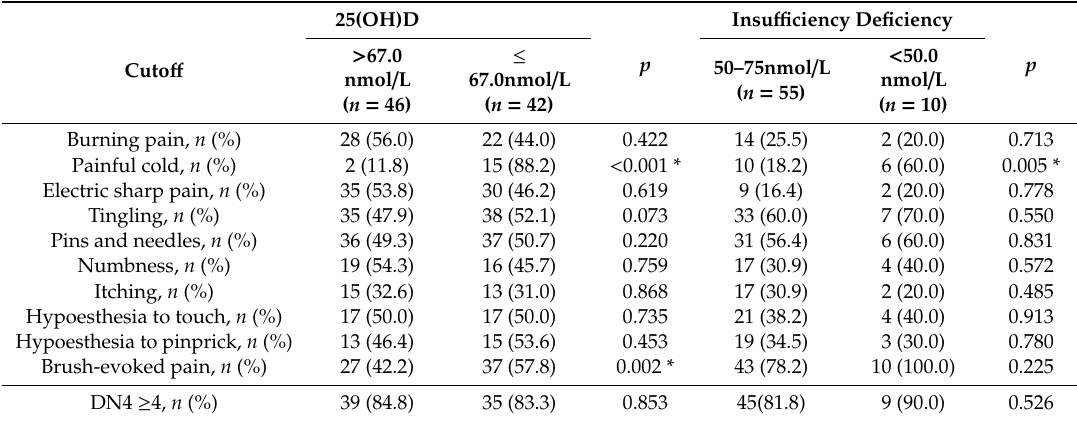
Table 4. Proportions of items in the DN4 questionnaire between patients with serum 25(OH)D concentration > the cuto ff value vs. ≤ the cuto ff value.